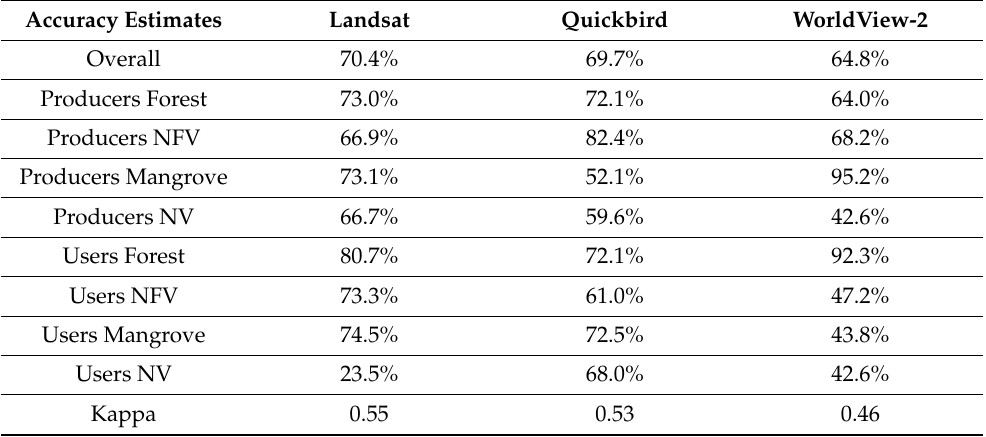
Table 5. Accuracy assessments of satellite image classifications of Babeldaob Island, Palau by vegetation cover class and